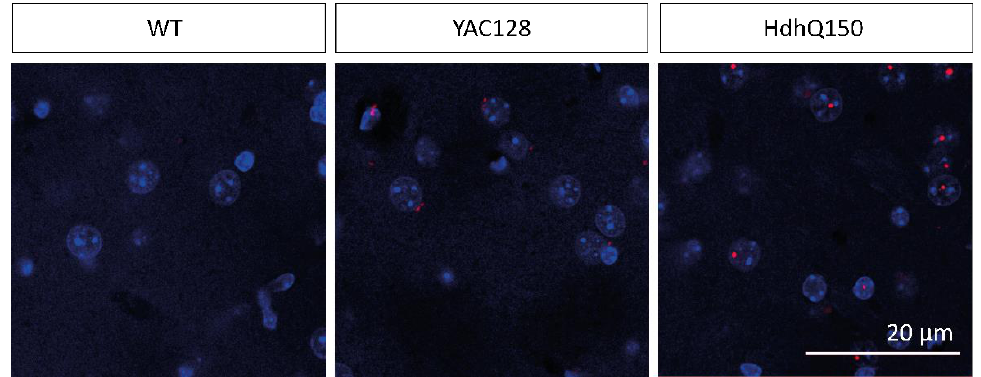
Figure 5. The number of inclusion bodies is lower in YAC128/BL6 than in HdhQ150Q/BL6 mice. Confocal microscopy images of brain slices of the striatum of WT (12 month), YAC128/BL6 (12 month) and HdhQ150 (10 month) mice. Inclusion bodies (red) were visualized with an MW8 antibody and cell nuclei with DAPI staining (blue). Merged images show the inclusion bodies with an intranuclear localization in HdhQ150 animals.